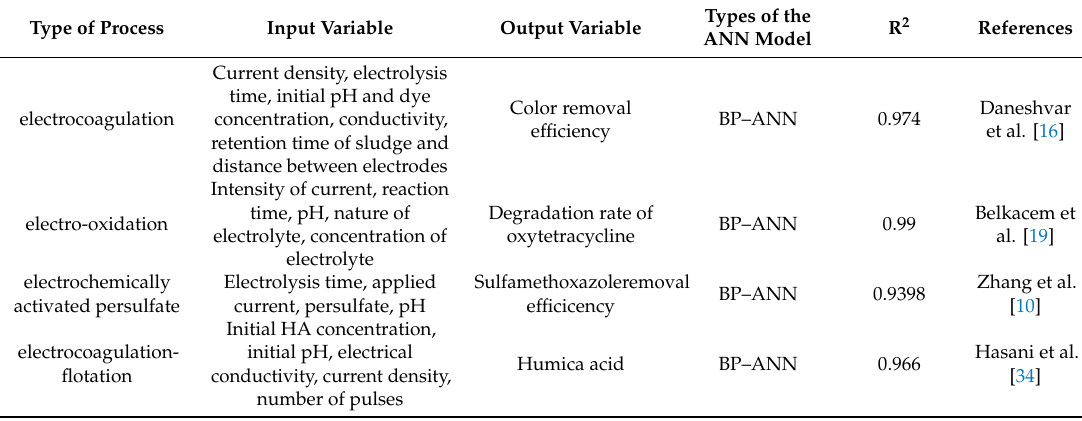
Table A3. ANN models for applications in various electrochemical